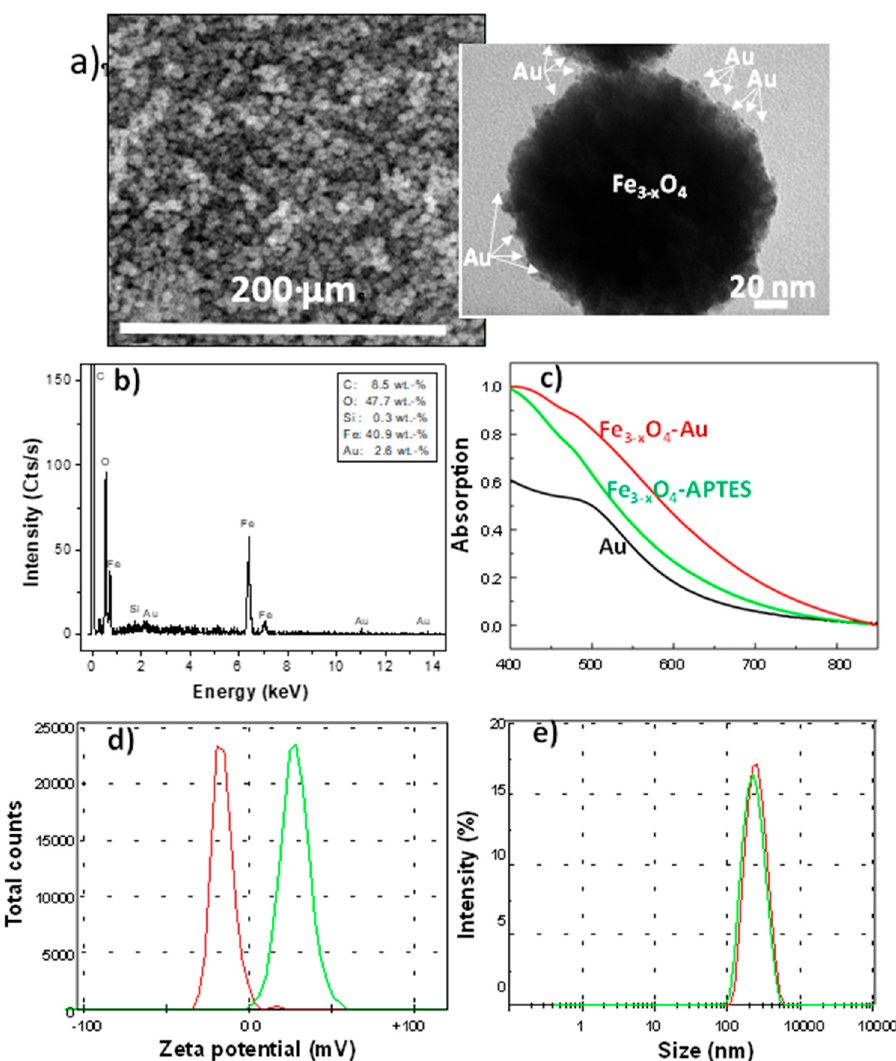
Figure 4. ( a ) SEM micrograph of an assembly of Fe 3-x O 4 -Au hybrids and ( b ) its related EDS spectrum. In the insert, a TEM picture of one representative hybrid. ( c ) UV-Vis spectrum of gold colloid (black line) compared to those of Fe 3-x O 4 functionalized by APTES (green line) and then coated by gold satellites (red line). ( d ) Zeta potential distribution of the hybrids (red line) compared to that of Fe 3-x O 4 particles just coated with APTES (green line) when dispersed in deionized water. ( e ) Hydrodynamic size distribution as inferred from DLS measurement on the same suspensions (the size polydispersity index PDI was found to be 0.48 before grafting and 0.07 after grafting).